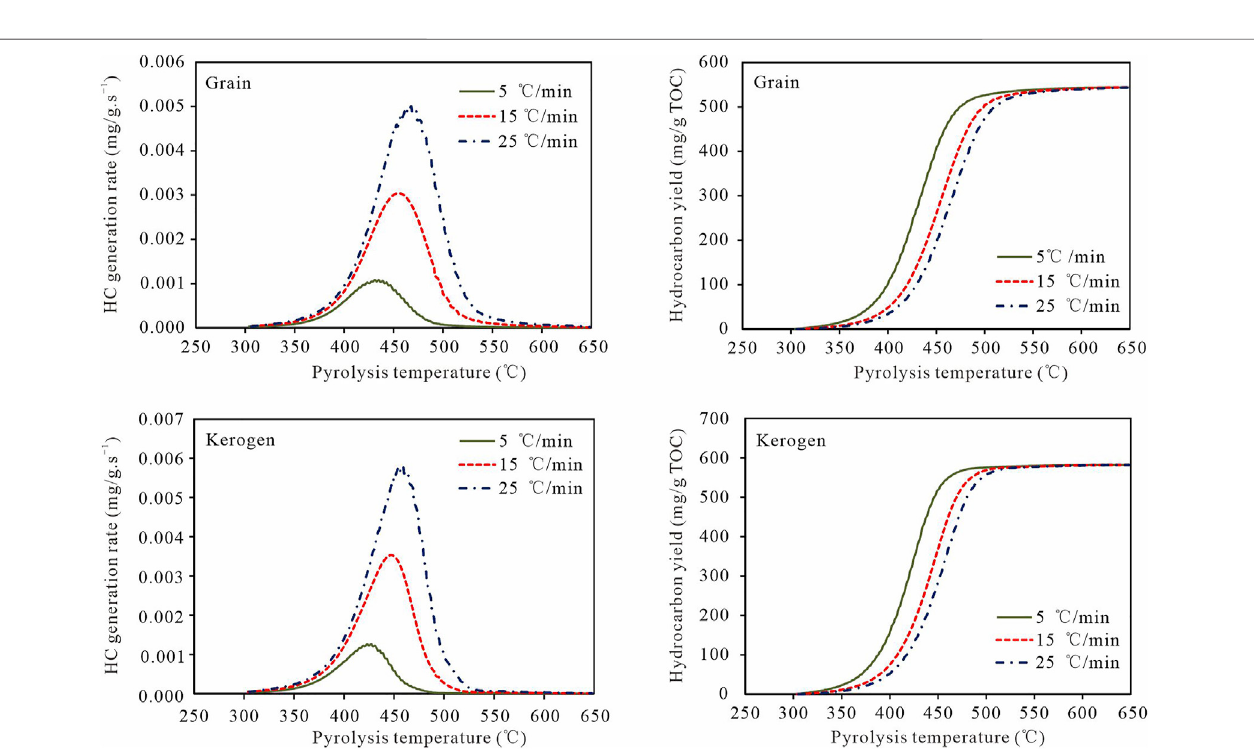
FIGURE 3 | Hydrocarbon (HC)-generating rates and hydrocarbon yield of grain and kerogen from SHJ shale as a function of pyrolysis temperature at different heating rates.